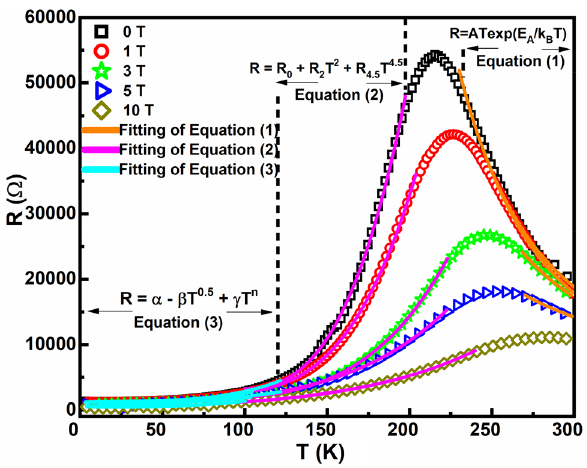
Figure 7. R(T) curve for different fields illustrating the fitting to understand the electrical conduction mechanism in the three different regimes.